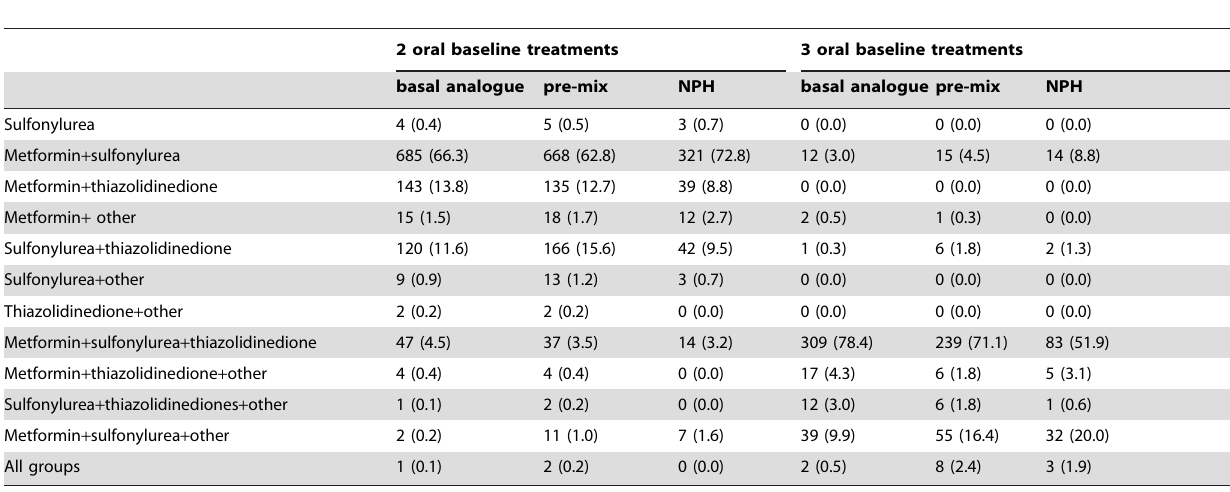
Table 2. Glucose-lowering therapy prescribed in the 112 days before starting insulin by insulin type and number of baseline oral therapies a ( n (% of cohort)).